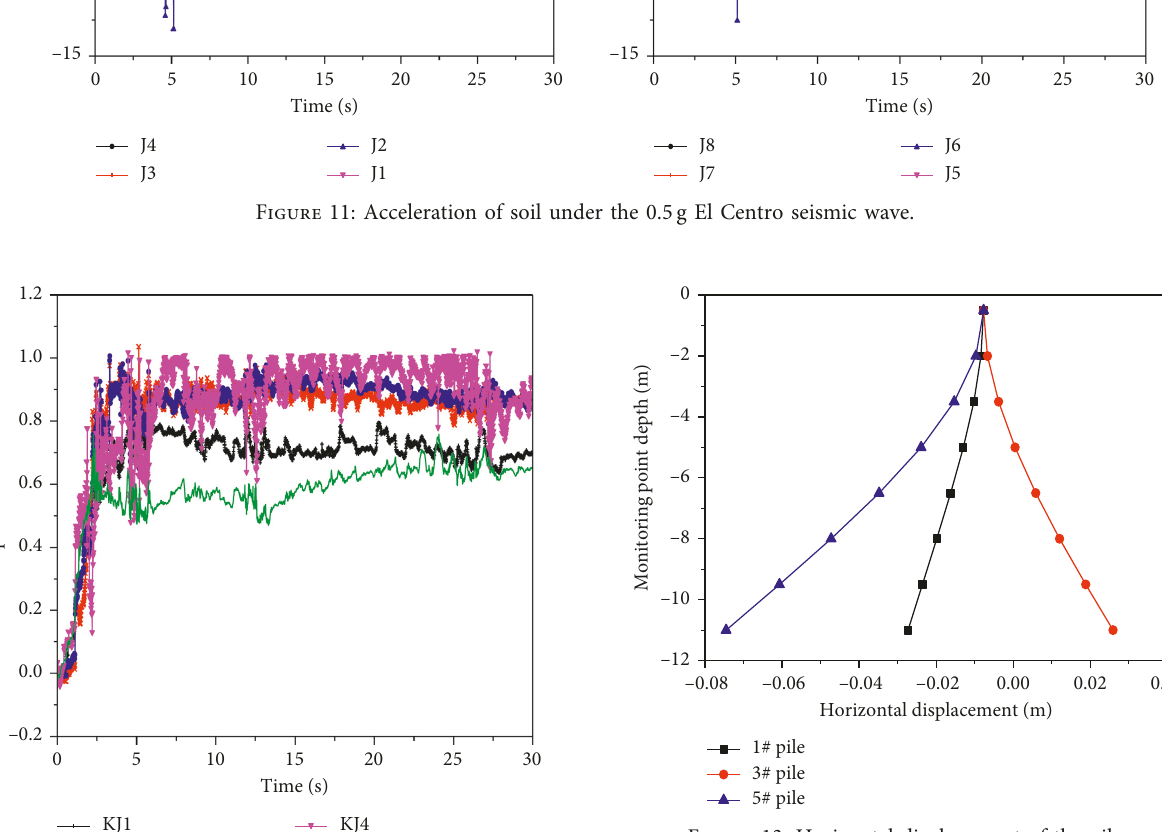
Figure 13: Horizontal displacement of the